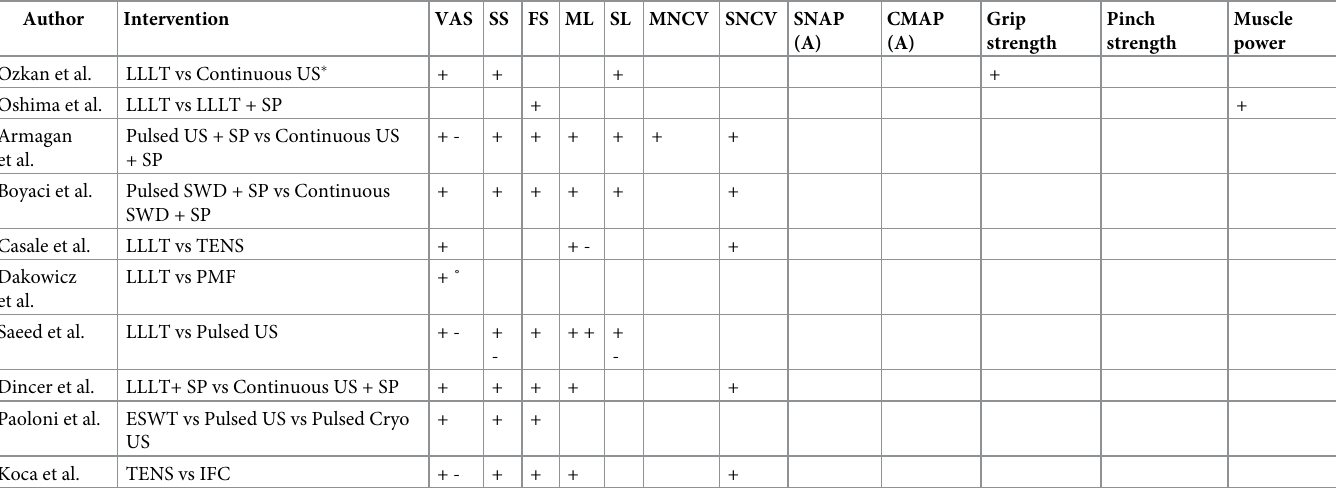
Table 3. Outcome measures and significance of the comparison between electrophysical modalities.